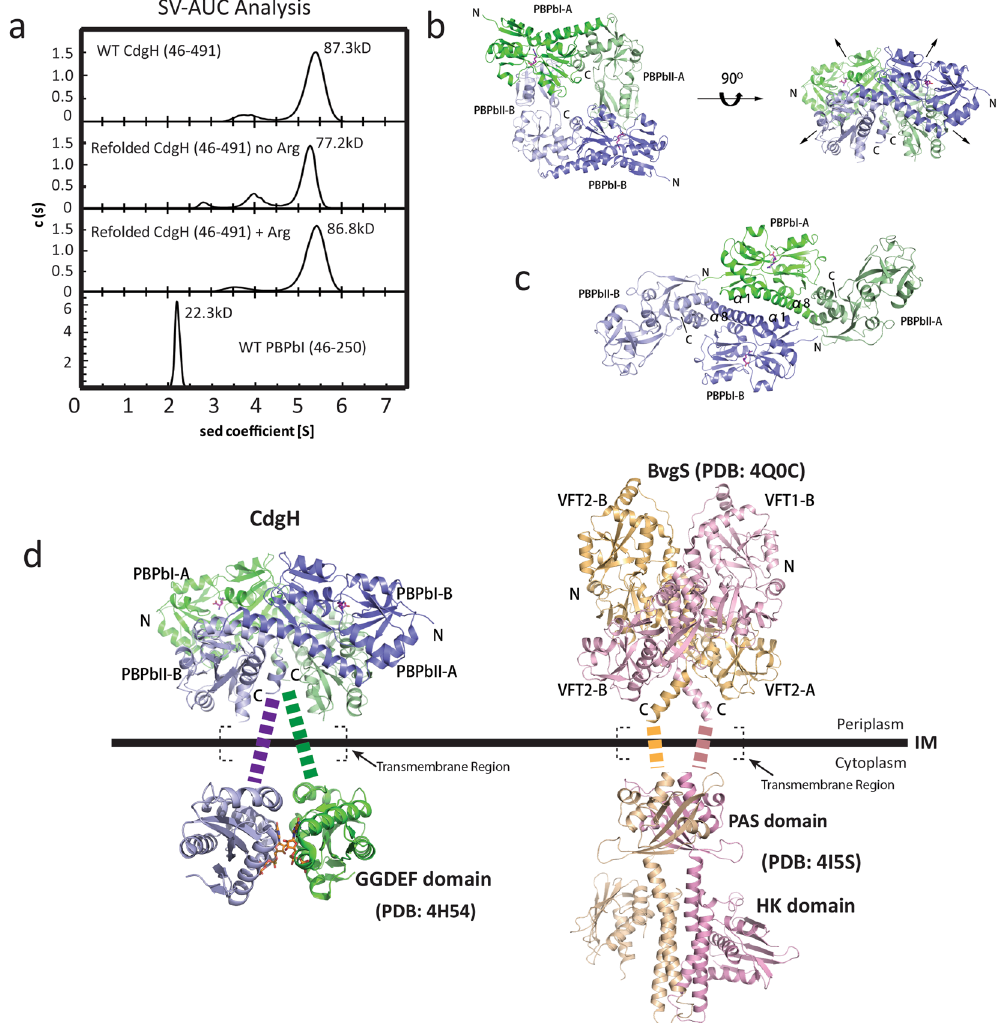
Figure 5. The dimerization of the periplasmic portion of CdgH. ( a ) The SV-AUC results of the wild-type CdgH (46–491), refolded CdgH (46–491), refolded CdgH (46–491) with L-arginine, and the wild-type PBPb-I domain. The calculated molecular mass of the samples are indicated beside the peaks. ( b ) Top view and side view of the type-I dimeric assembly of CdgH (46–491). ( c ) The overall structure of the type-II dimeric assembly of CdgH (46–491). The PBPb-I and -II domains of molecule A are shown in green and light green, respectively, and those of molecule B are shown in blue and light blue, respectively. ( d ) Comparison of the dimeric assemblies of CdgH and BvgS. The cartoon model of the GGDEF domain is generated from the structure of a zinc-sensory diguanylate cyclase from E. coli (PDB ID: 4H54). Substrate analog GTP α S molecules are shown as orange sticks. The cartoon model of the tandem periplasmic domains of BvgS is generated from the structure of BvgS (PDB ID: 4Q0C). The cartoon model of PAS (Per-Arnt-Sim) and HK (Histidine Kinase) domains of BvgS is generated from the structure of VicK from Streptococcus mutans (PDB ID: 4I5S). The transmembrane regions of both models are indicated by dash